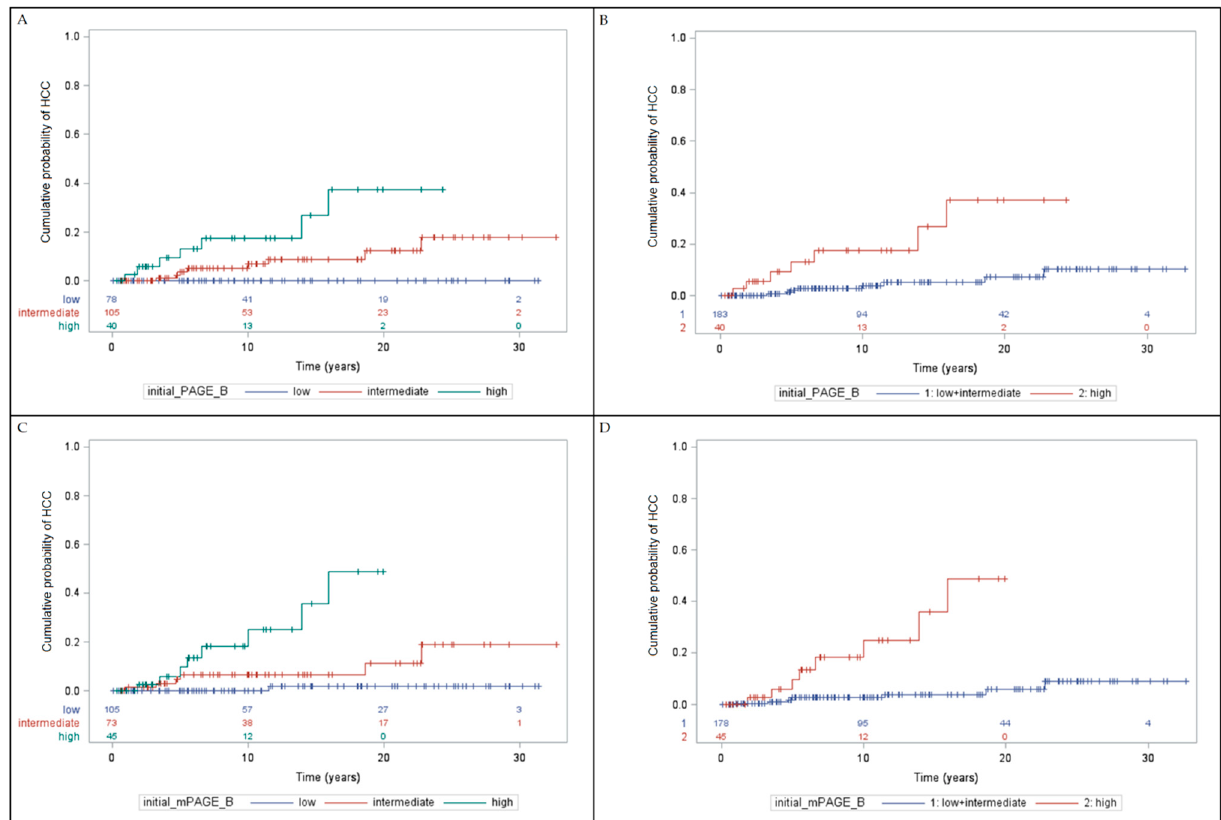
Figure 3. Cumulative probability of hepatocellular carcinoma stratified by the scores. A: Initial